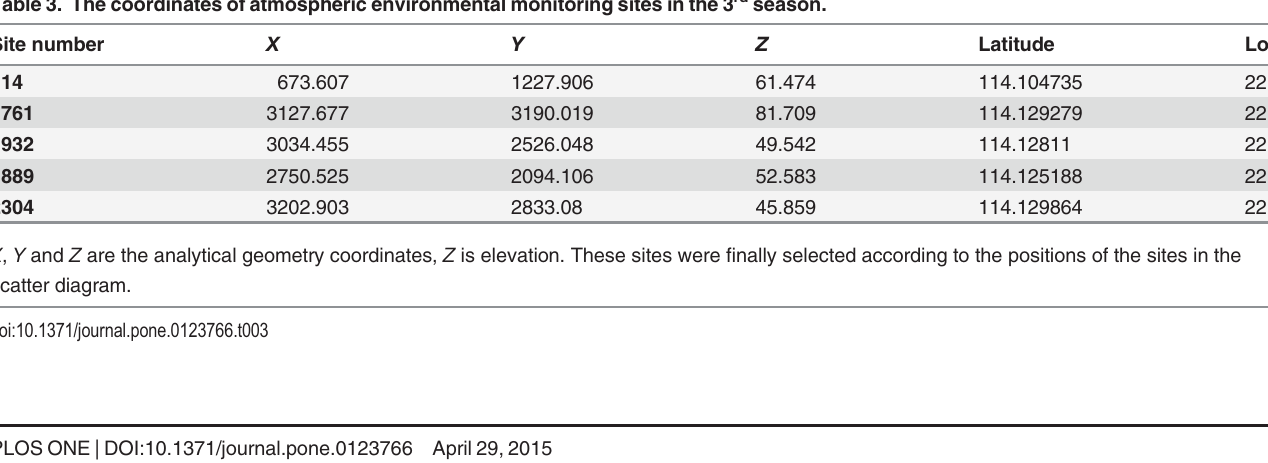
Step 4 The calculated coordinates were transformed inversely into latitude and longitude.